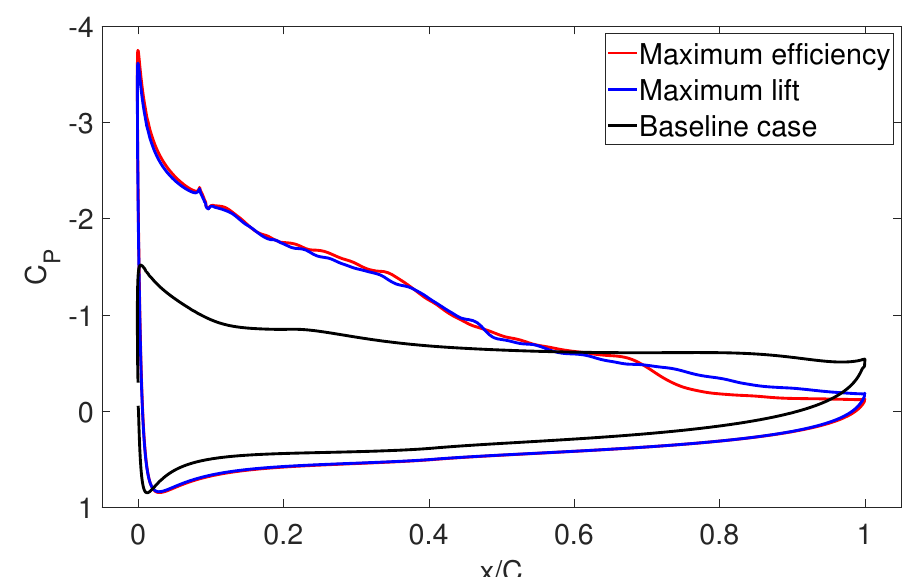
Figure 10. Pressure coefficient comparison for the baseline case and maximum efficiency and maxi- mum lift configurations.